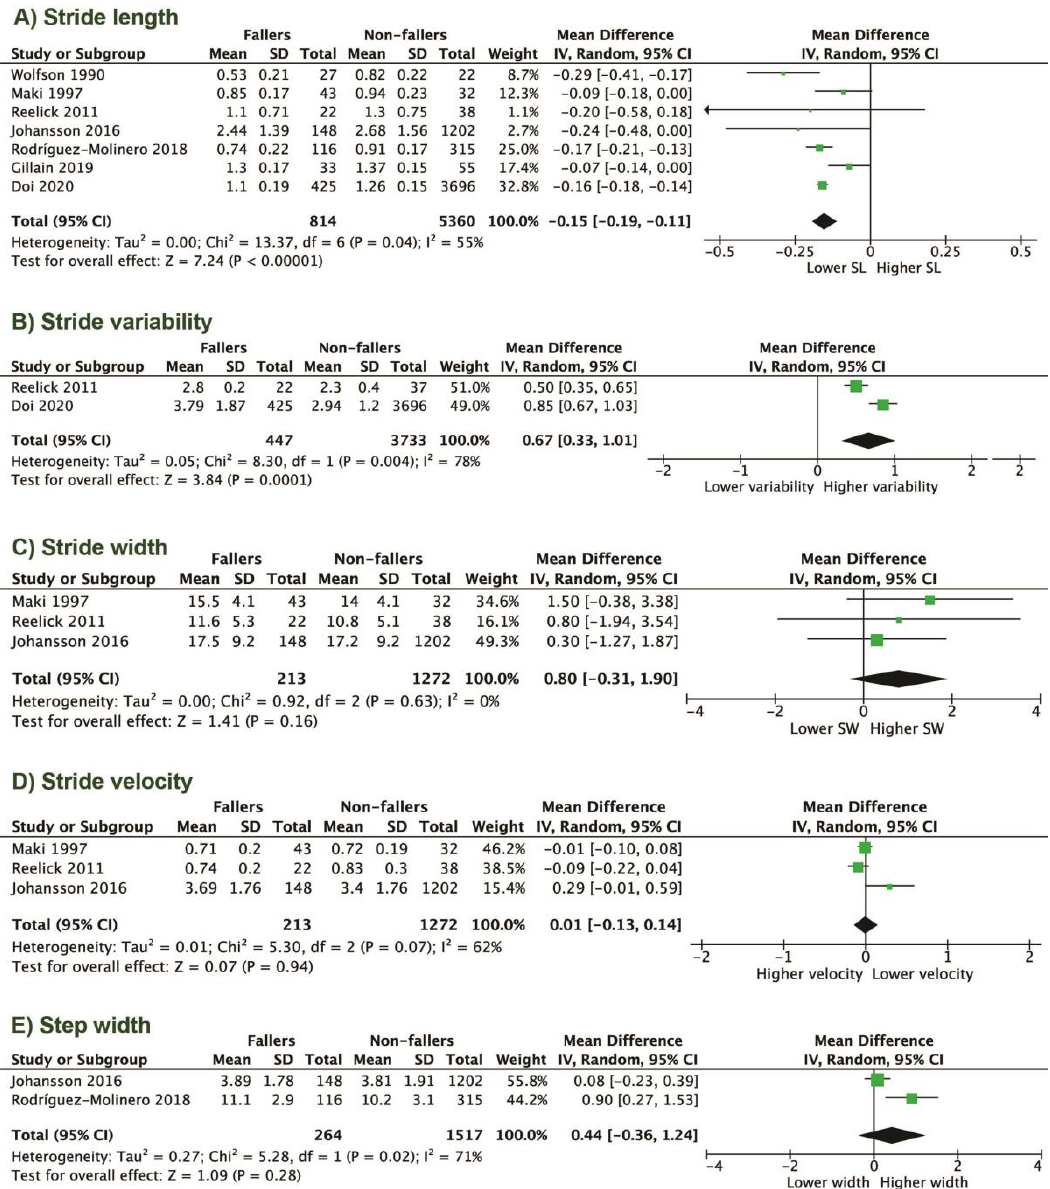
Figure 2. Gait parameters in fallers compared to non-fallers: ( A ) stride length; ( B ) stride variability; ( C ) stride width; ( D ) stride velocity; ( E ) step